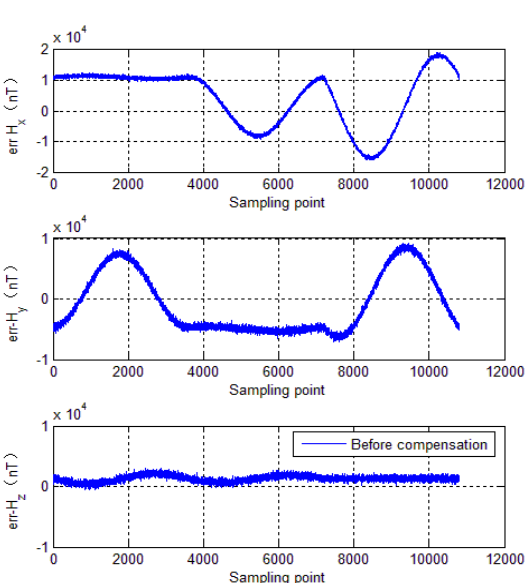
Figure 13. Measurement error before calibration.